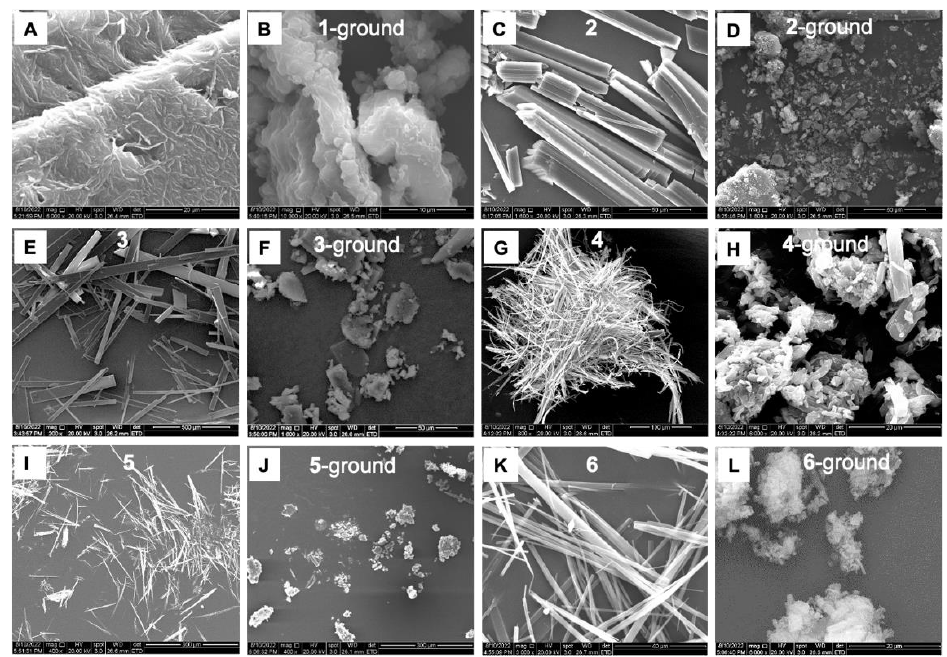
Figure 6. SEM images of 1 – 6 were taken before and after grinding.